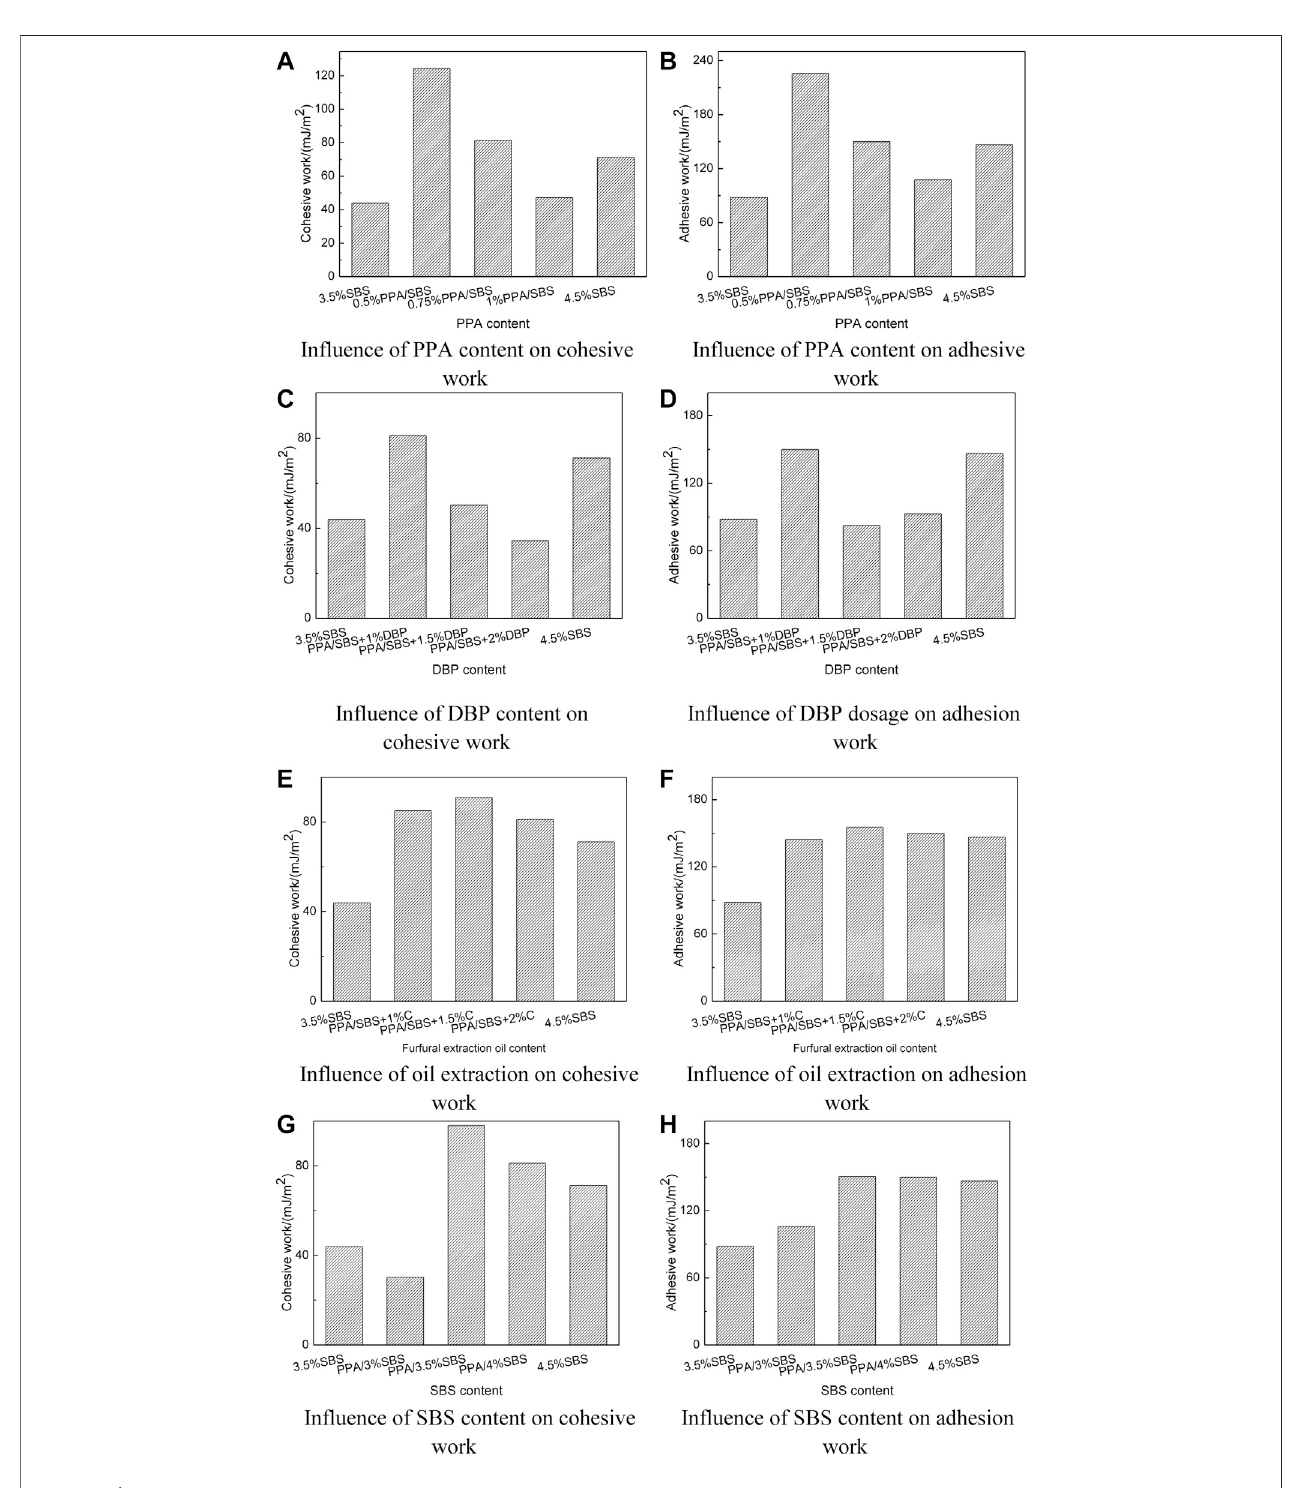
FIGURE 5 | Effect of the raw materials ’ content on PPA/SBS modi fi ed asphalt ’ s adhesion characteristics. (A) In fl uence of PPA content on cohesive work. (B) In fl uence of PPA content on adhesive work. (C) In fl uence of DBP content on cohesive work. (D) In fl uence of DBP dosage on adhesion work. (E) In fl uence of oil extraction on cohesive work. (F) In fl uence of oil extraction on adhesion work. (G) In fl uence of SBS content on cohesive work. (H) In fl uence of SBS content on adhesion work.